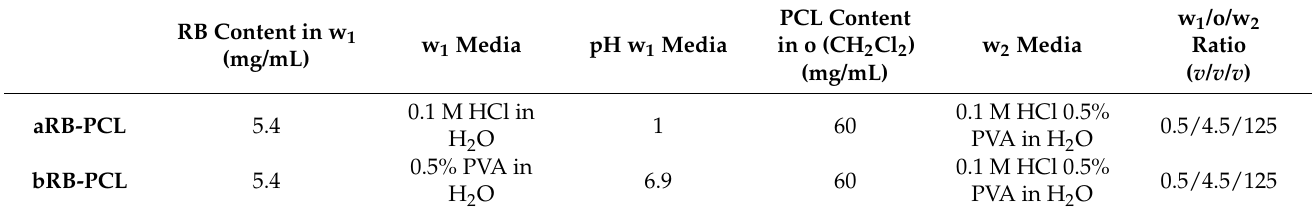
Table 1. Formulative parameters employed for the preparation of RB–PCL